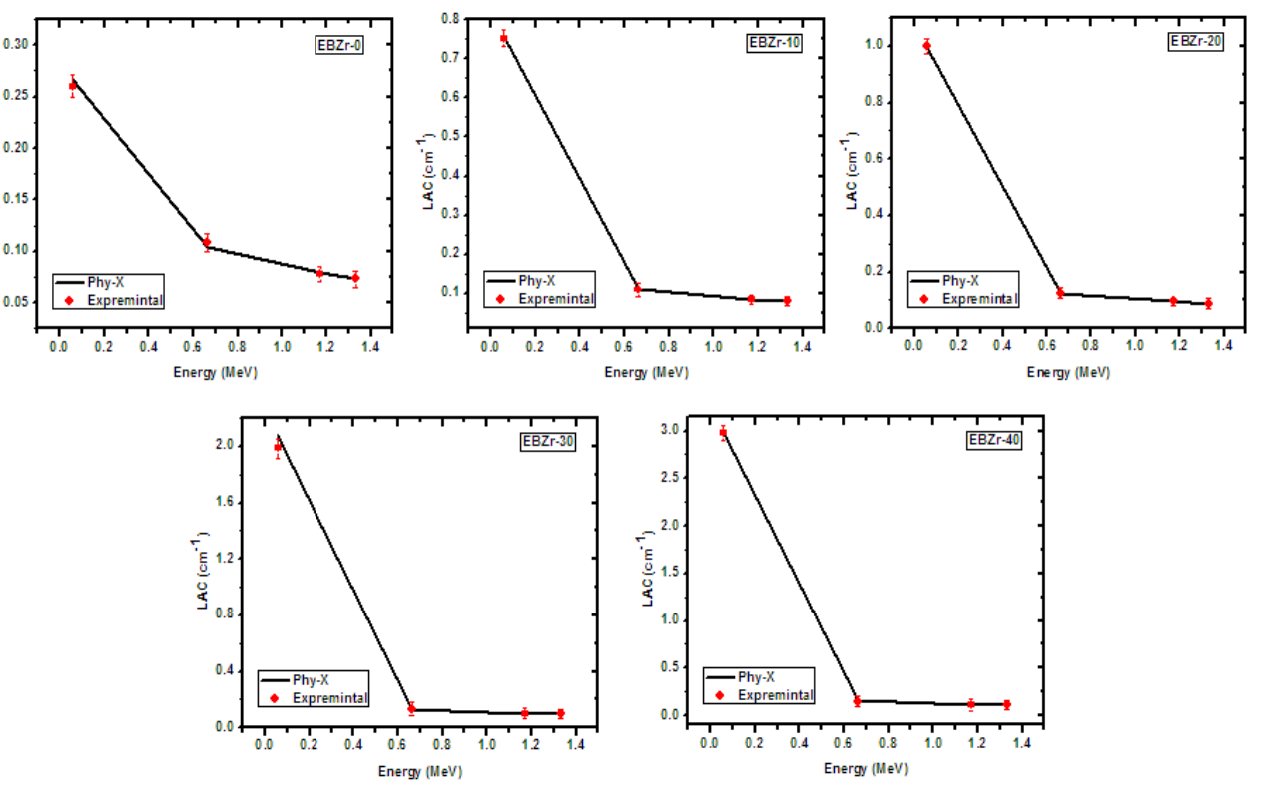
Figure 3. Comparison between the experimental and Phy-X linear attenuation coefficients for the new epoxy composites.